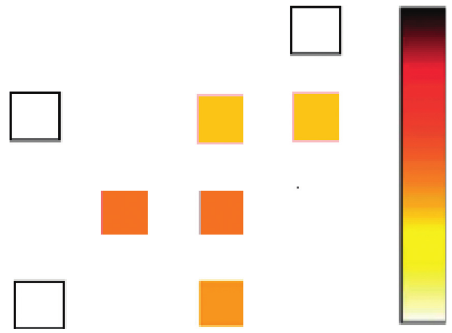
Figure 8: The thermal layouts of proposed